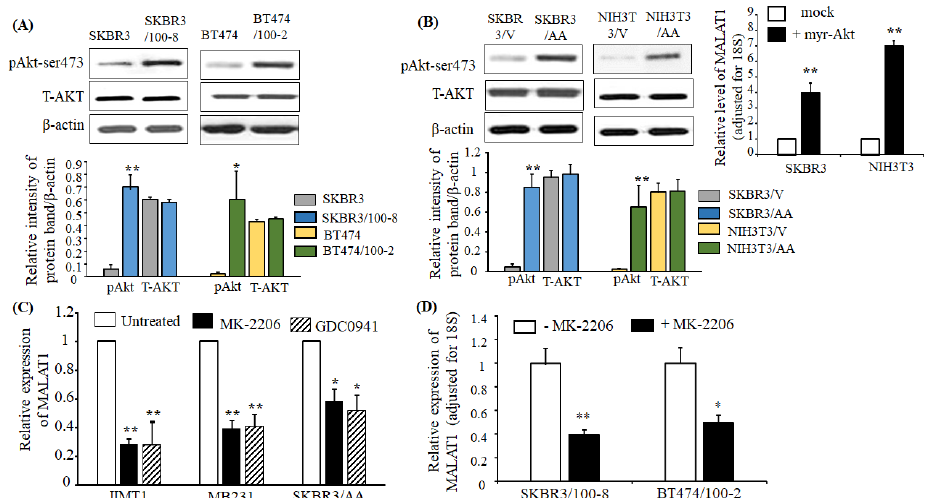
Figure 4. The PI3K / Akt pathway mediates the expression of MALAT1. ( A ). Total protein was extracted from each cell line, and western blot analysis was performed with antibodies specific to phosphorylated Akt at ser- 473 (pAkt) and total AKT (T-AKT). β -actin was used for loading control. The top panel shows representative western blot images, and the bottom panel shows quantification by densitometric analysis of western blots from four independent experiments. pAkt and T-AKT protein levels are shown relative to β -actin. The bars indicate mean ± SEM. Increased pAkt was observed in the trastuzumab-resistant cells compared to their parental lines, respectively (* p < 0.05 and ** p < 0.01). An ANOVA test was used to determine significance. ( B ). SKBR3 and NIH3T3 were stably transfected with myr-Akt ( + myr-Akt) or with vector only (mock). The western blot images in the left-top panel show representative protein expression of pAkt, T-AKT, and β -actin. The bottom panel shows quantification by densitometric analysis of protein (pAkt / β -actin or T-AKT / β -actin) levels from four di ff erent western blots. The bars indicate mean ± SEM, and demonstrate elevated pAkt in SKBR3 / AA and NIH3T3 / AA (** p < 0.01) compared to respective SKBR3 / V and NIH3T3 / V cell lines. An ANOVA test was used to determine significance. The right-top panel shows the levels of MALAT1 relative to 18S RNA, as determined by RT-qPCR. The bar graph indicates the mean ± SEM from four independent experiments. Myr-Akt transfected cells show increased MALAT1 expression, ** p < 0.01, compared to mock cells. Significance was determined using the ANOVA test. ( C ). The indicated cell lines were treated with MK-2206 or GDC0941 for 48 h, and RT-qPCR was used to determined MALAT1 relative to 18S expression. Each bar indicates mean ± SEM from four independent experiments. The data showed that MK-226 and DGC0941 inhibited expression of MALAT1 in JIMT, MB231, SKBR3 / AA cells (* p < 0.05 and ** p < 0.01) compared with their respective untreated cells. An ANOVA test was used to determine